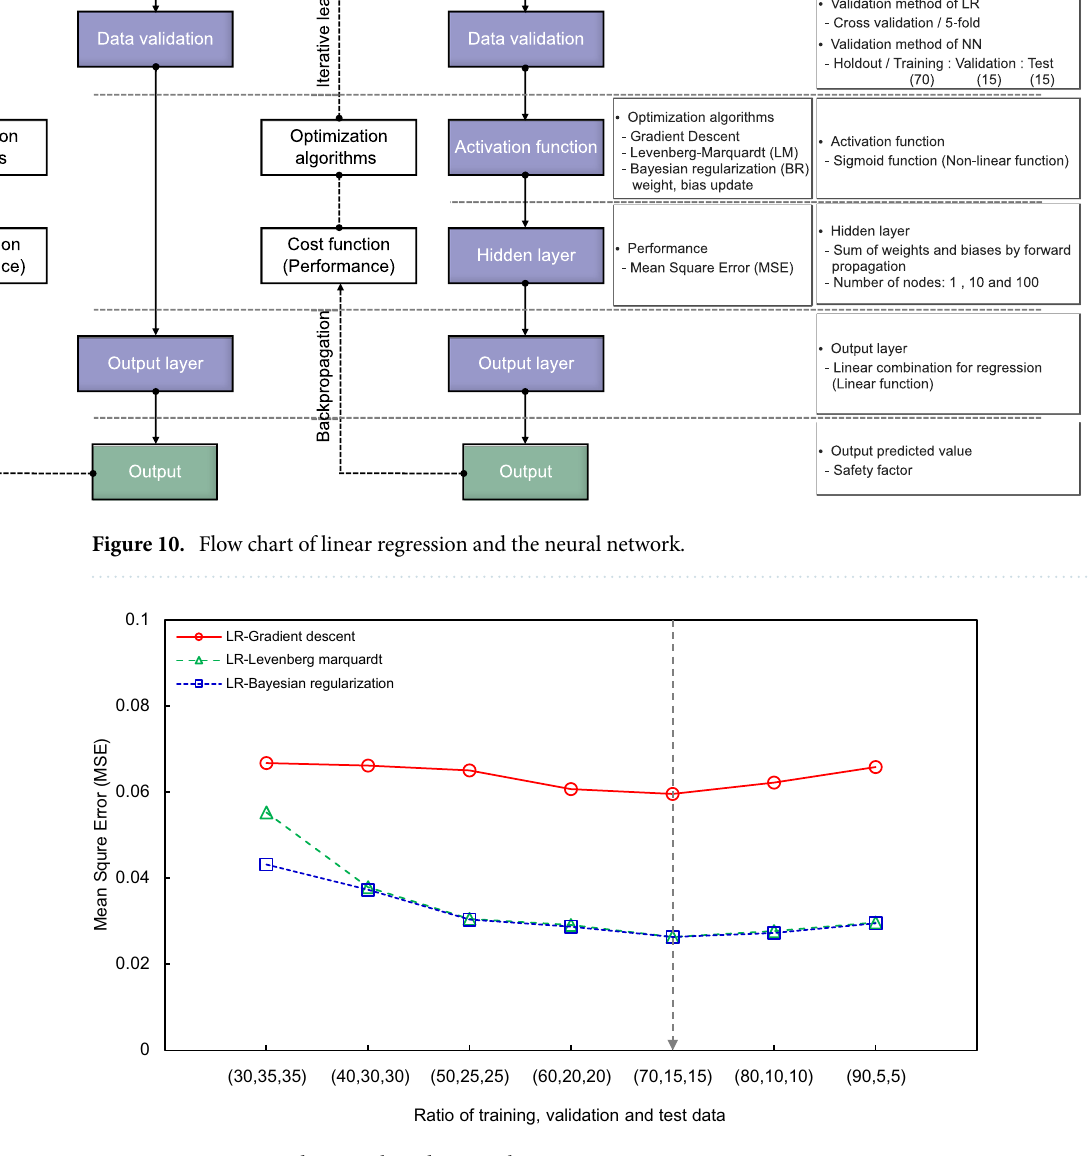
Figure 11. MSE according to selected ratio in linear